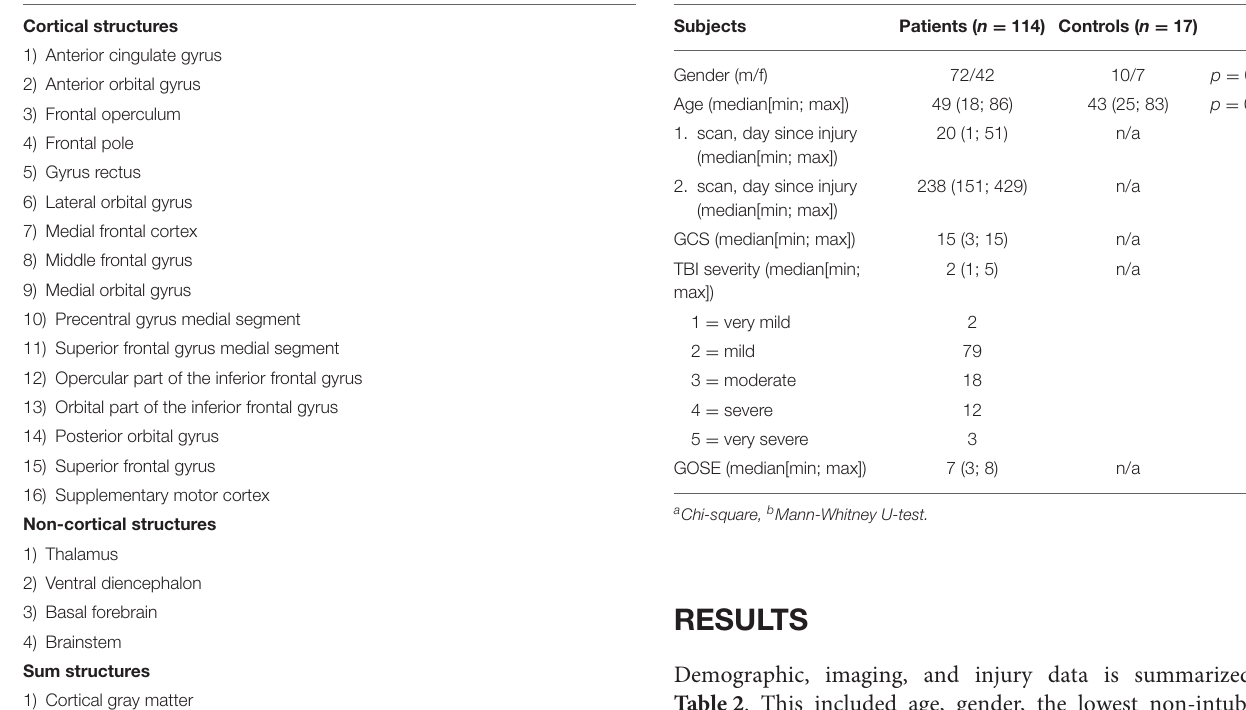
TABLE 1 | Structures selected to analyses. TABLE 2 | Study population